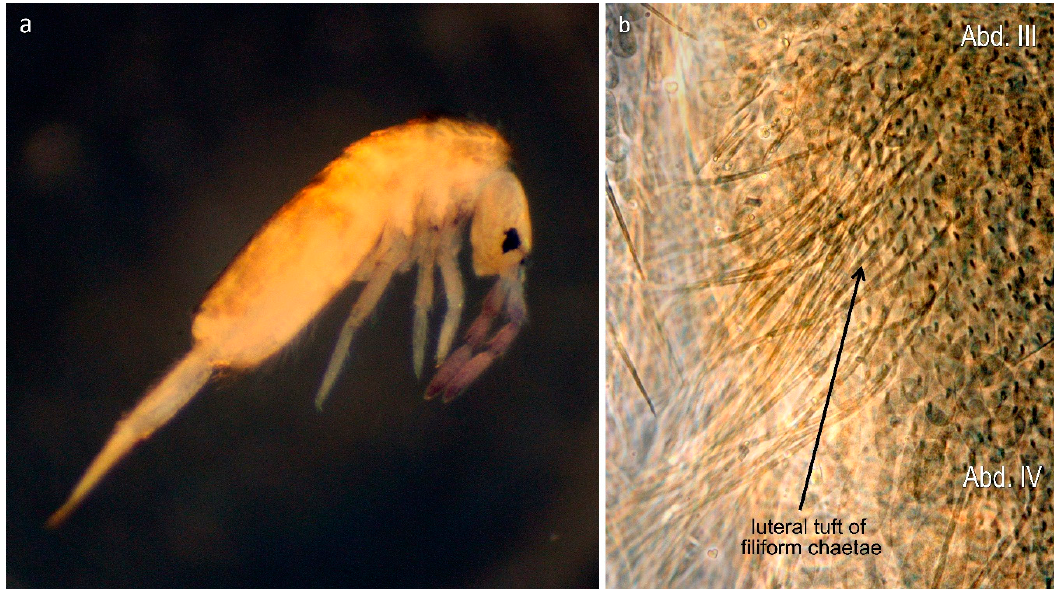
Figure 3. Lepidocyrtus peisonis: ( a ) Habitus; ( b ) tuft of filiform chaetae on the lateral part of Abd. III.